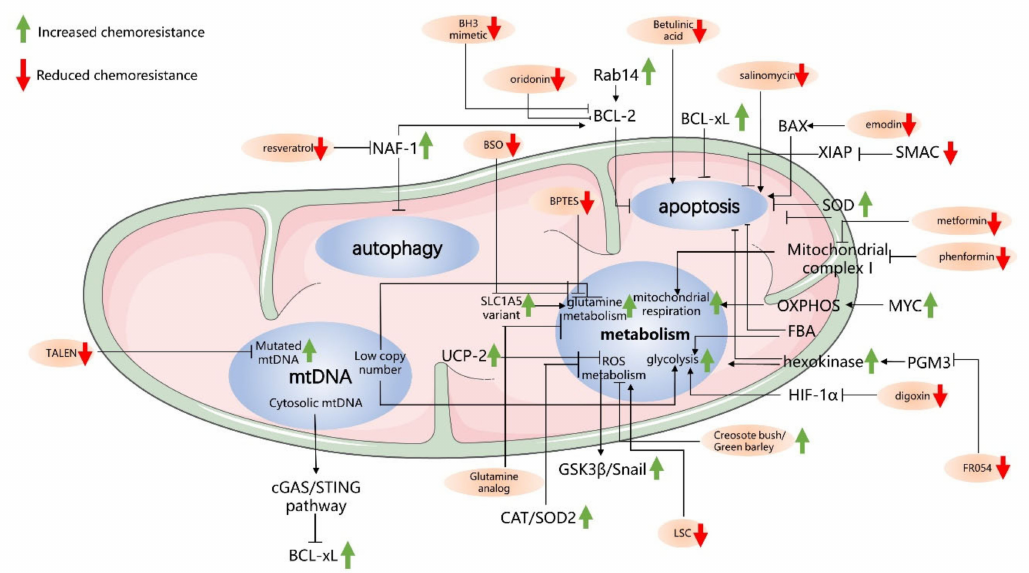
Figure 4. The mechanism of mitochondria-mediated chemoresistance in pancreatic cancer cells and ways to overcome it. In pancreatic cancer cells, mutated mitochondria induce chemoresistance via many mechanisms, including the inhibition of apoptosis, regulation of autophagy, altered metabolism, and mtDNA mutation. Many drugs and treatments that target these mutations are being studied to overcome chemoresistance in PC